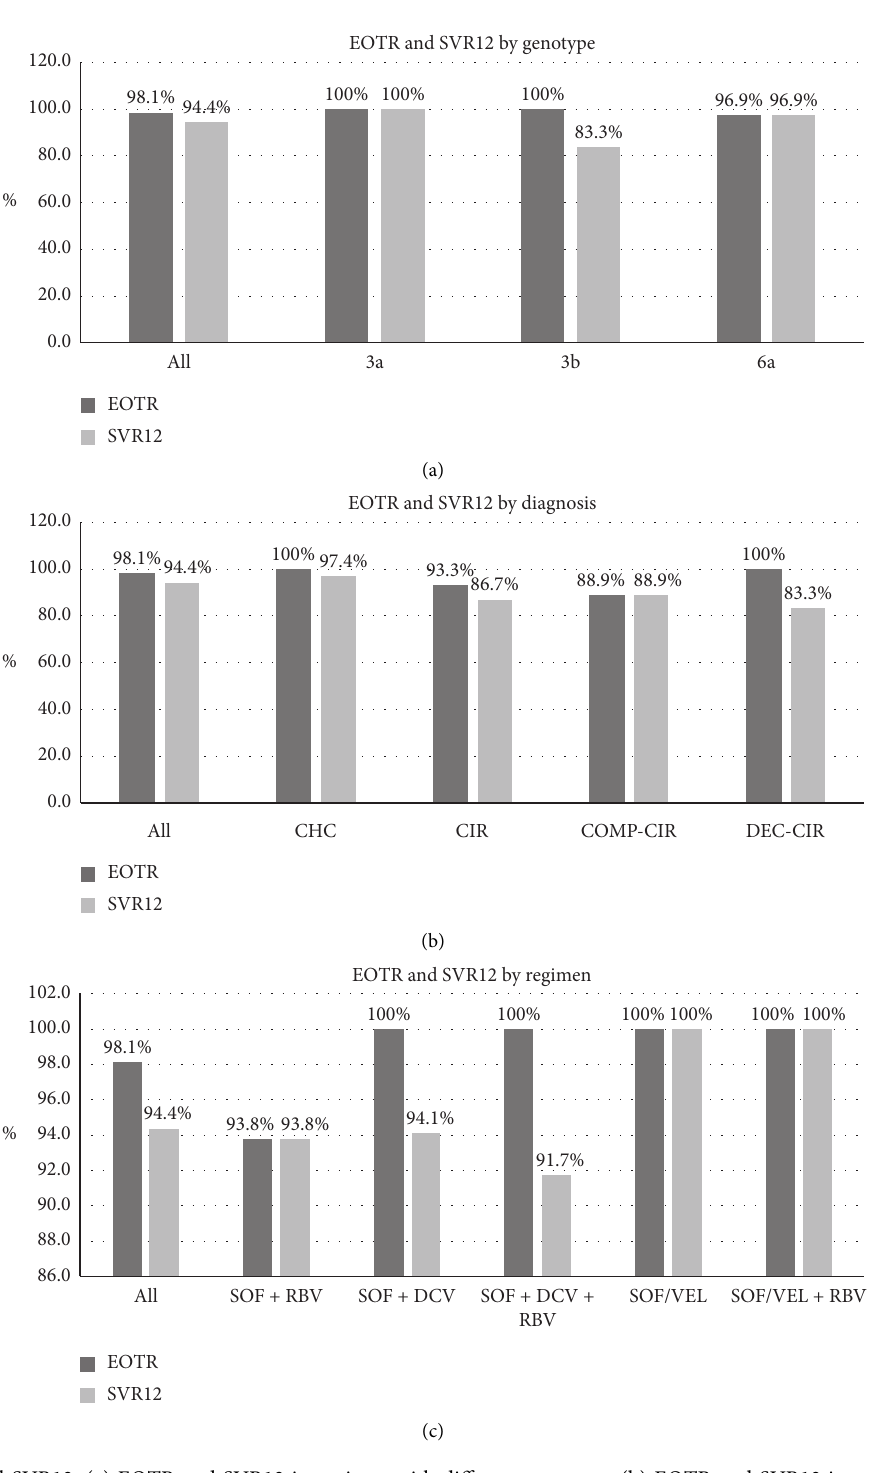
Figure 2: EOTR and SVR12. (a) EOTR and SVR12 in patients with different genotype. (b) EOTR and SVR12 in patients with different diagnosis. (c) EOTR and SVR12 in patients with different treatment